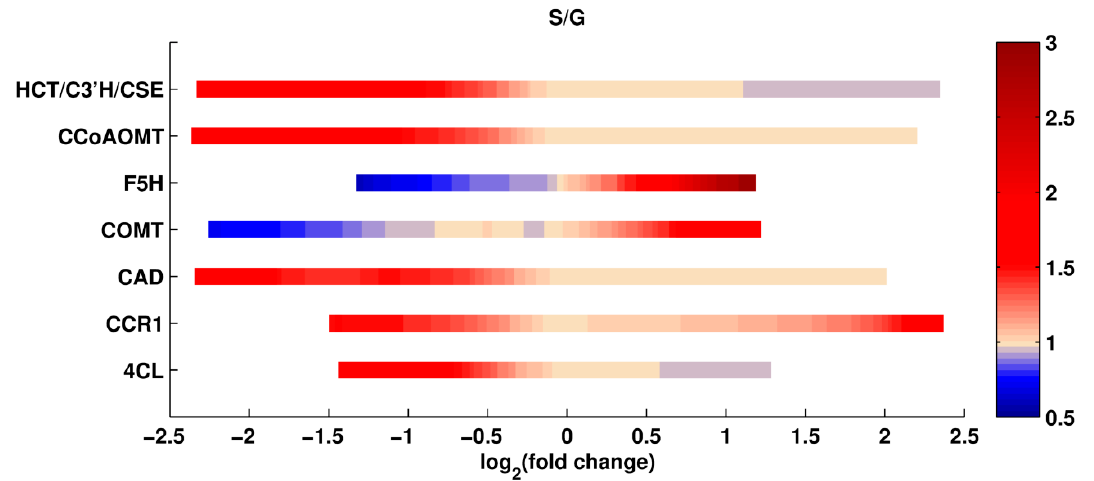
Figure 3. S/G ratios in response to single enzyme perturbations. Blue represents decreases in S/G ratios, red represents increases, while white is the wild type base level. F5H seems to be the most effective enzyme for altering the S/G ratio, both toward increases and decreases. Similar to the total lignin response, changes in S/G ratios are not necessarily monotonic: the S/G ratio increases in both knocked down and overexpressed CCR1.